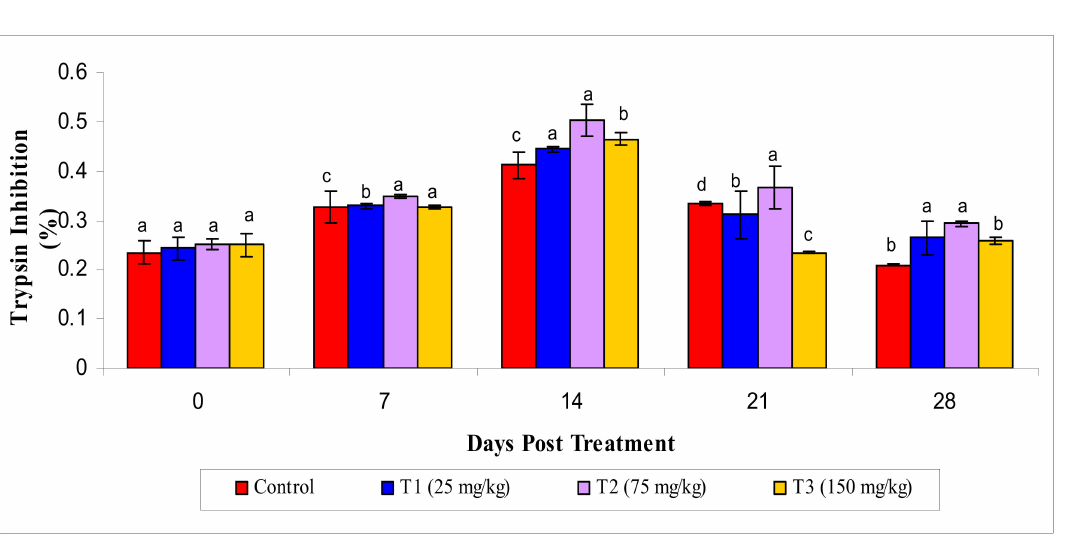
Figure 5. Serum antiprotease activity under di ff erent treatments administered with various levels of methanol extract of Chaetomorpha antennina in Labeo rohita during post treatment days (values are mean ± SE). a,b,c,d Mean values with di ff erent superscripts considered as statistically di ff erent ( p < 0.05); n = 6 for each treatment